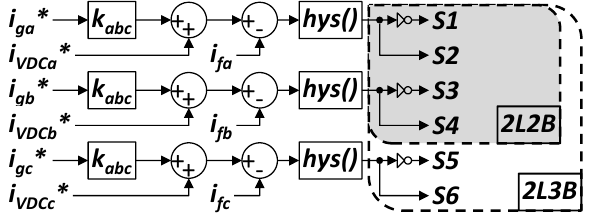
Figure 7. Hysteresis modulation technique applied to the